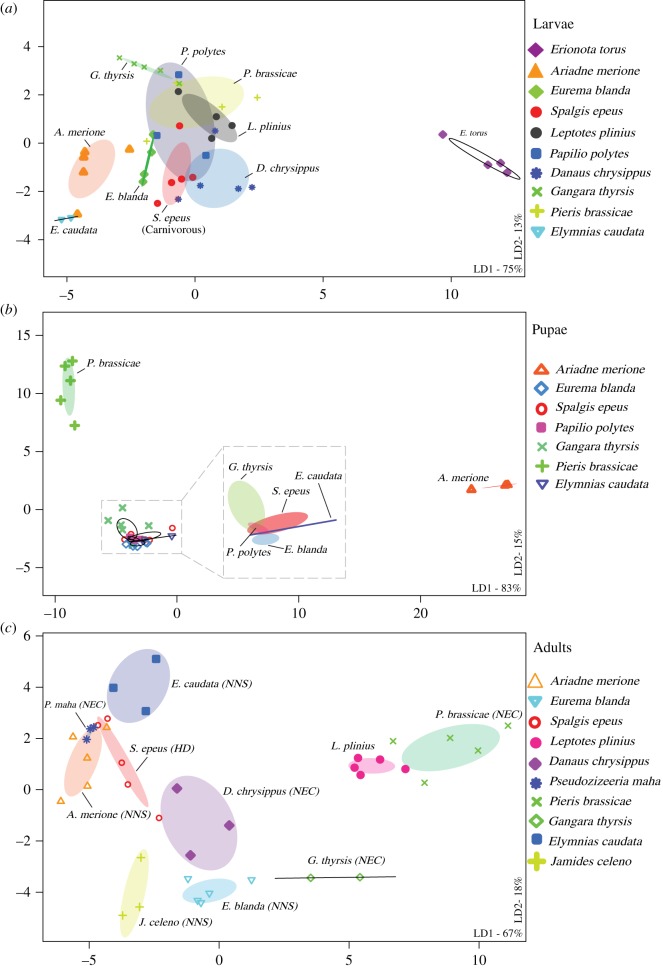
Variation in bacterial communities of developmental stages of different butterfly host species. Panels show constrained analysis of principal coordinates (CAP) for larvae (a), pupae (b) and adults (c) based on the composition and relative abundance of bacterial OTUs after applying a 5% abundance cut-off. Axis labels indicate the proportion of between-group variance (%) explained by the first two linear discriminants (LD1 and LD2). Ellipses represent 95% confidence intervals. For each panel, we observe a significant effect of host species (p < 0.05, multivariate ANOVA). Carnivorous S. epeus larvae (a) and the adult dietary resource (table 1) of each butterfly species are marked (c). In panel (b), the plot area marked with a square is expanded to clearly show ellipses. In panel (a), the impact of host species remained significant even after removing the potential outlier E. torus larvae (electronic supplementary material, figure S12; MANOVA, p < 0.05).